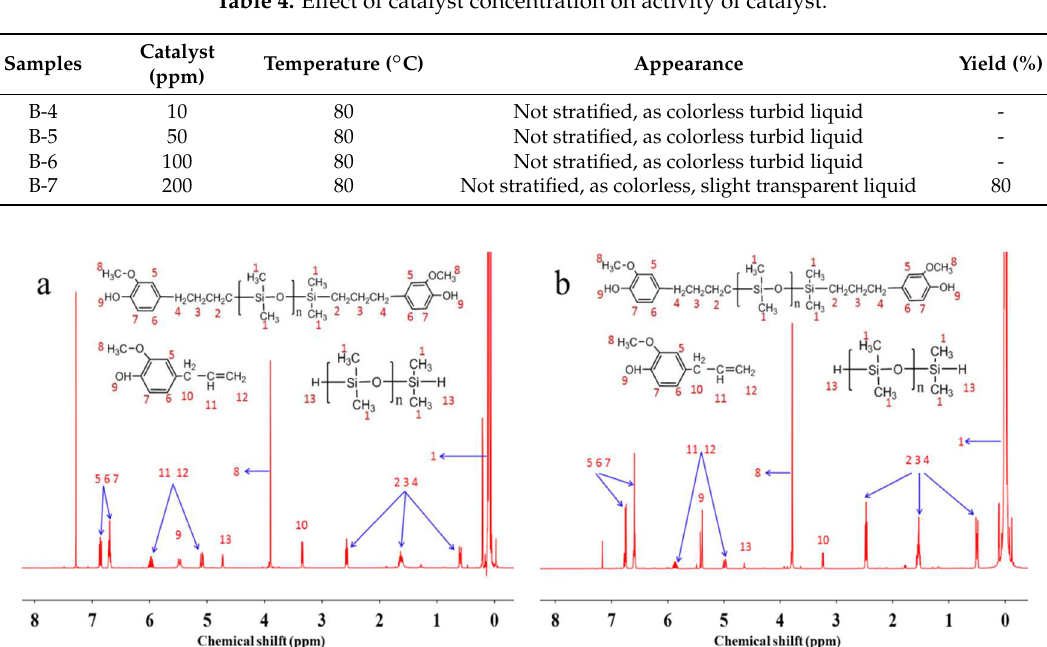
Figure 3. 1 H NMR spectrum of sample B-3 ( a ) and B-7 ( b ).